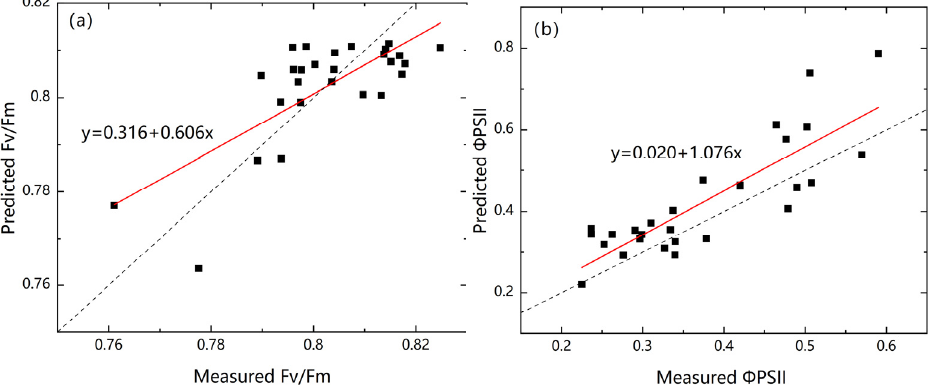
Figure 11. Predictive models of Fv / Fm ( a ) and Φ PSII ( b ). The dotted line represents the prediction model in an ideal state, and the red line represents the real prediction model.